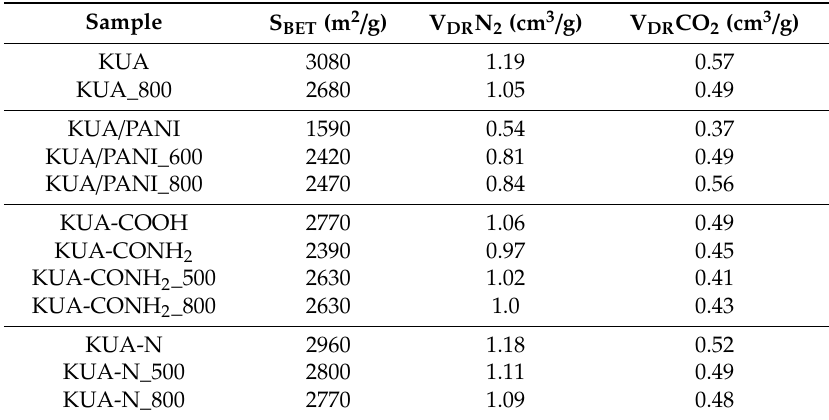
Table 3. Porous texture of the